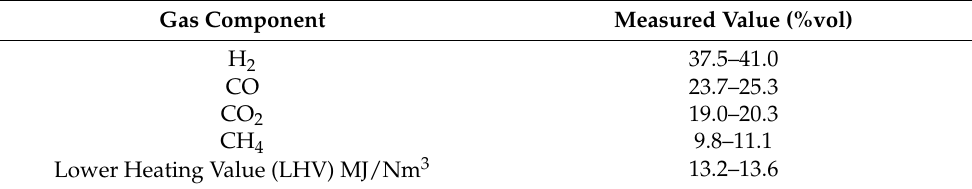
Table 5. Main gas composition in the clean product gas (dry basis) from all test sets.